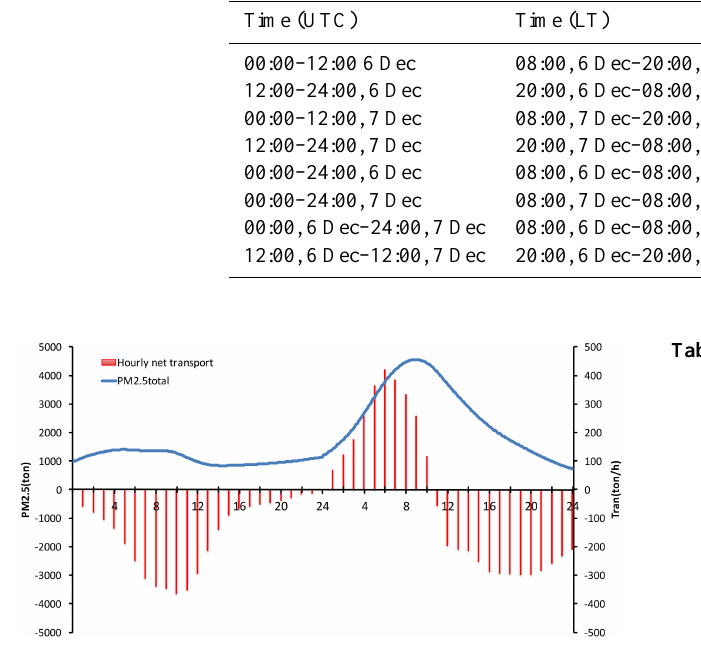
Figure 9. Total PM 2 . 5 (ton) suspended in the atmosphere from the surface to 3000m over the BJ area and the net hourly PM 2 . 5 input (tonh − 1 ) for BJ during 6–7 December 2013.